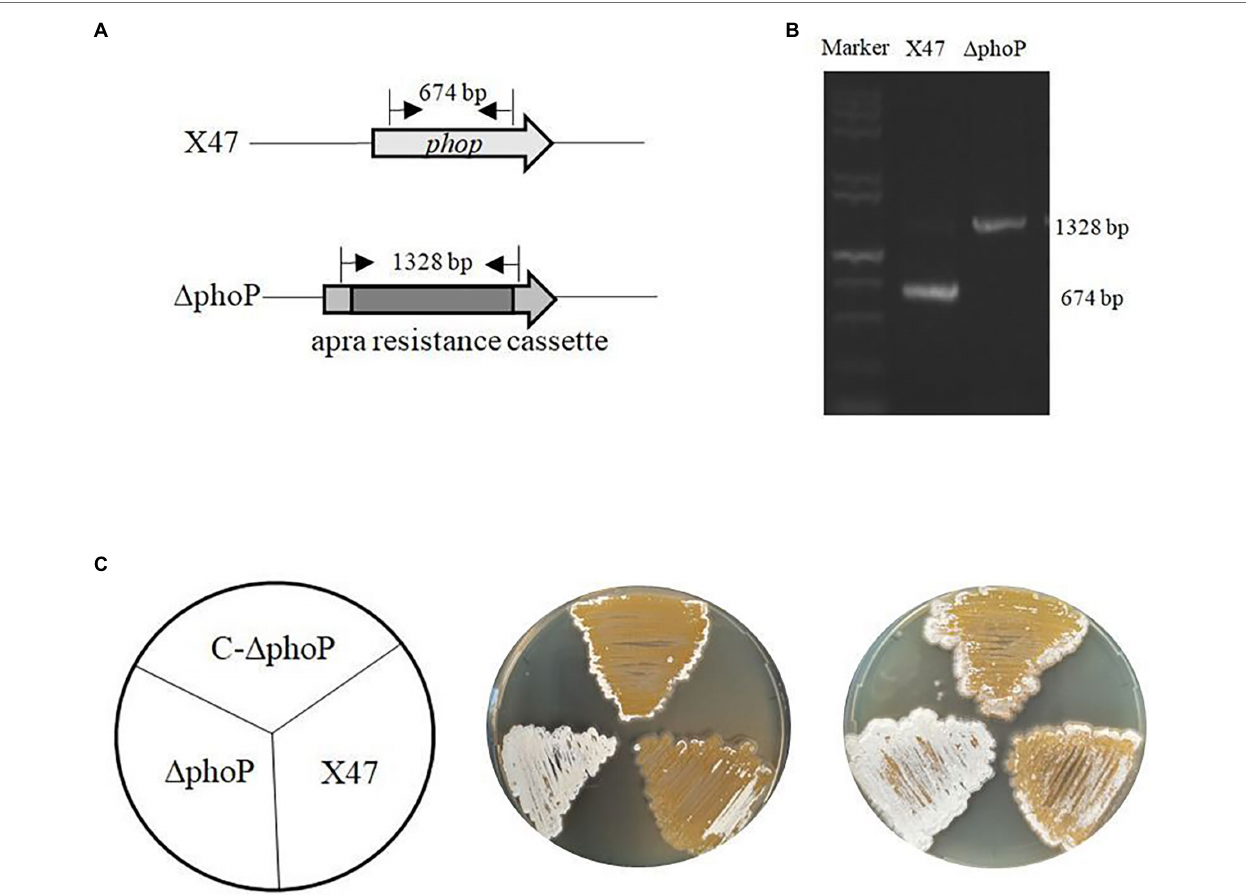
FIGURE 2 | Deletion of phoP accelerates morphological differentiation in A. pretiosum X47. (A) Schematic design showing replacement of a 674-bp internal sequence of phoP with an apramycin resistance cassette. (B) Confirmation of the phoP mutation by PCR analysis with primers flanking the deleted region. PCR products were electrophoresed on an agarose gel. (C) Phenotypes of the wild-type A. pretiosum strain X47, phoP mutant strain ∆ phoP, and complemented strain C- ∆ phoP grown at 30 ° C on ISP2 medium for 48 and 72